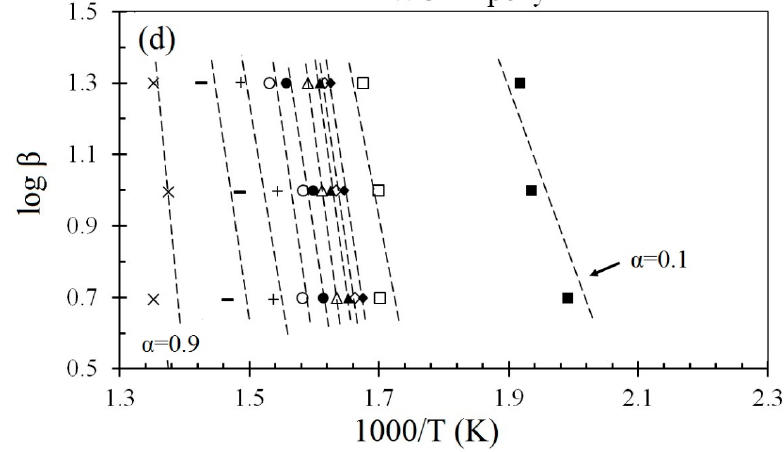
Figure 4. Plot of log β versus 1000/T at different heating rates according to the Flynn–Wall–Ozawa method at different conversion [ x = 0.9, - = 0.8, + = 0.7, o = 0.6, ● = 0.5, Δ = 0.4, ▲ = 0.3, ◊ = 0.25, ♦ = 0.2, □ = 0.15, ■ = 0.1] for ( a ) Epoxy00, ( b ) Epoxy/HYB1, ( c ) Epoxy/HYB, and ( d ) Epoxy/HYB5.